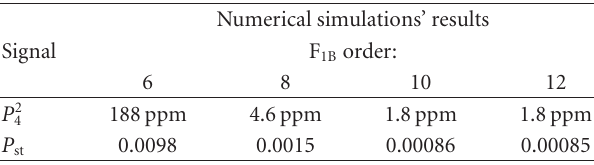
Table 1: Comparison of P 2 4 and P st values for real